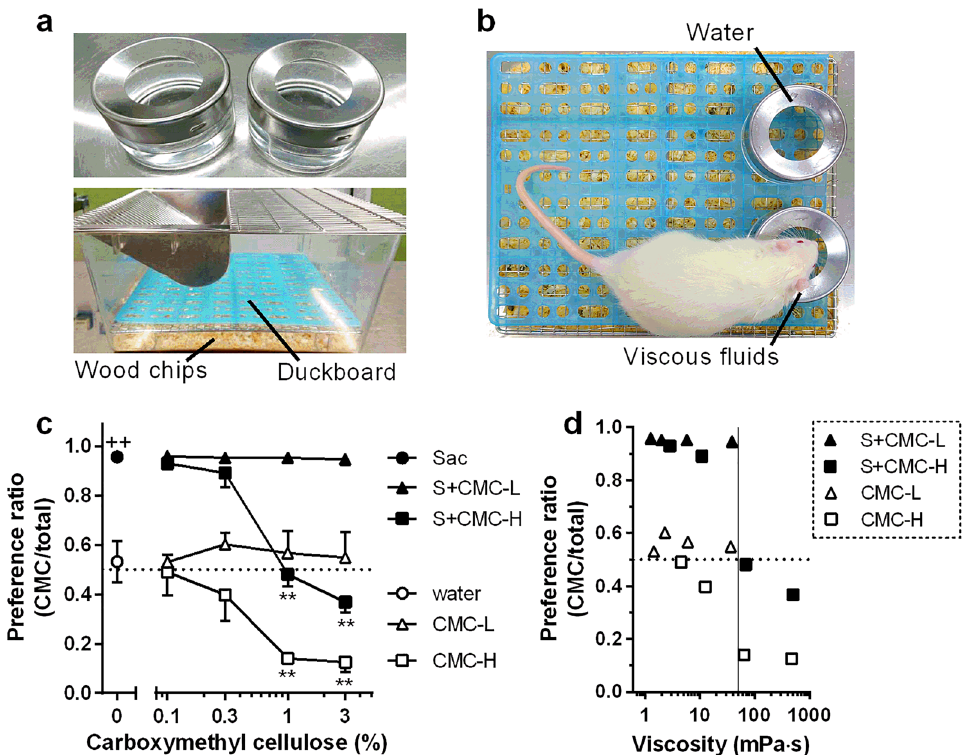
Figure 2. Preference for carboxymethyl cellulose (CMC) in rats. CMC-L, low-viscosity CMC fluid; S + CMC- L, saccharin-containing CMC-L fluid; CMC-H, high-viscosity CMC fluid; S + CMC-H, saccharin-containing CMC-H fluid. Mean ± standard error of the mean. ( a ) Photographs of glass jar containers and a cage used in the experiments. ( b ) Photographs of two-bottle preference tests. ( c ) Preference ratio of CMC-containing fluids (each point, n = 5). **, P < 0.01 against CMC-L or S + CMC-L fluid in Sidak’s post hoc test following two-way ANOVA test. ++ , P < 0.01 against water by unpaired two-tailed Student’s t test. ( d ) Relationship of viscosity and preference ratio of CMC-containing